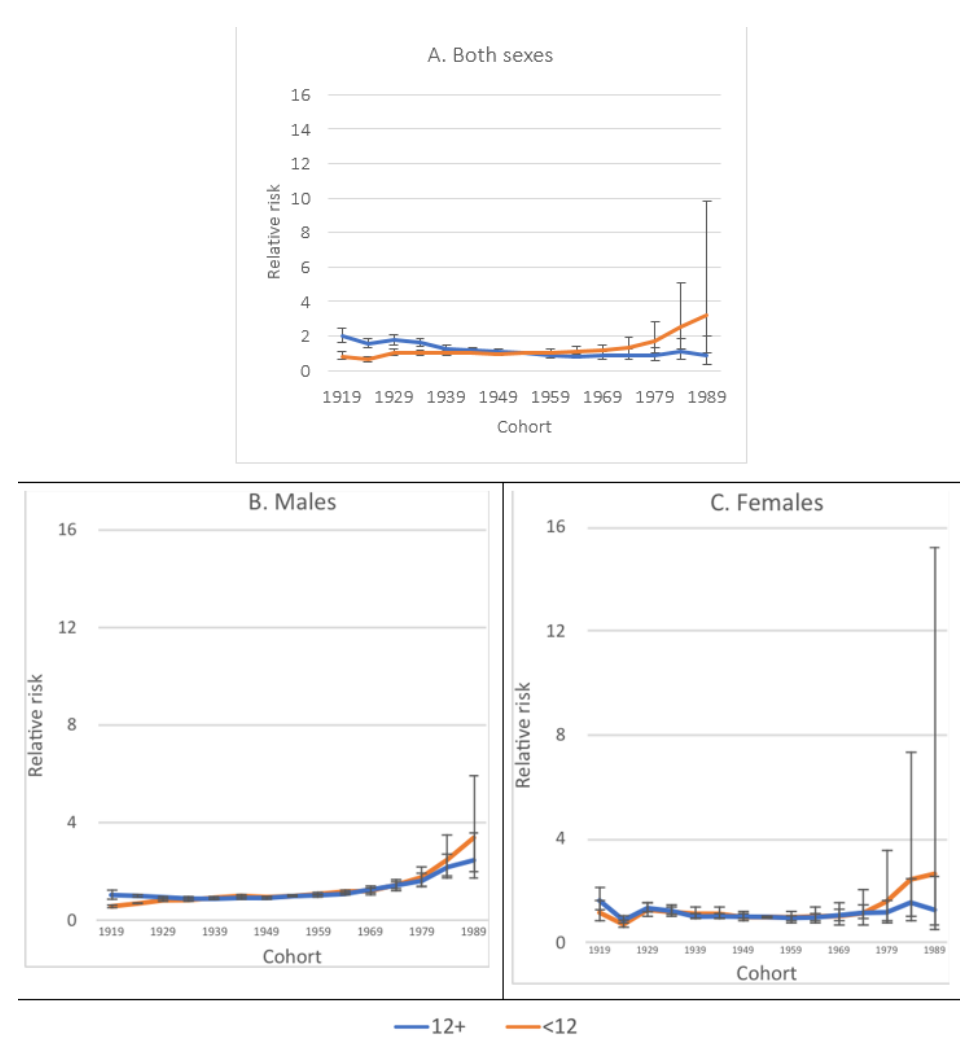
Figure 7. The relative risk of dying of diabetes among Hispanics in the USA by sex, birth cohort, and education level between 1989 to 2018. RR was compared to the 1954 cohort.